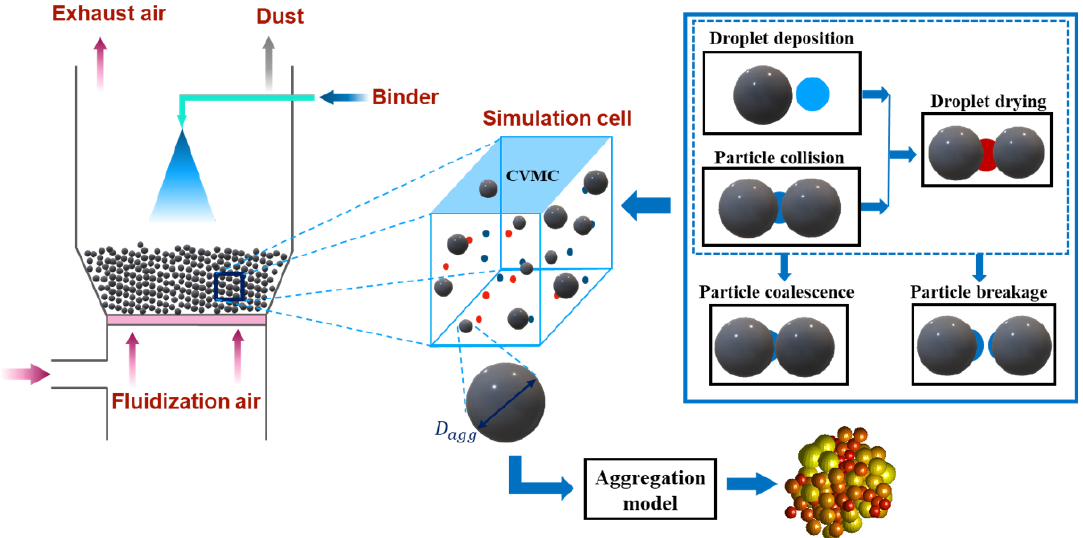
Figure 1. CVMC simulation framework for SFB agglomeration.